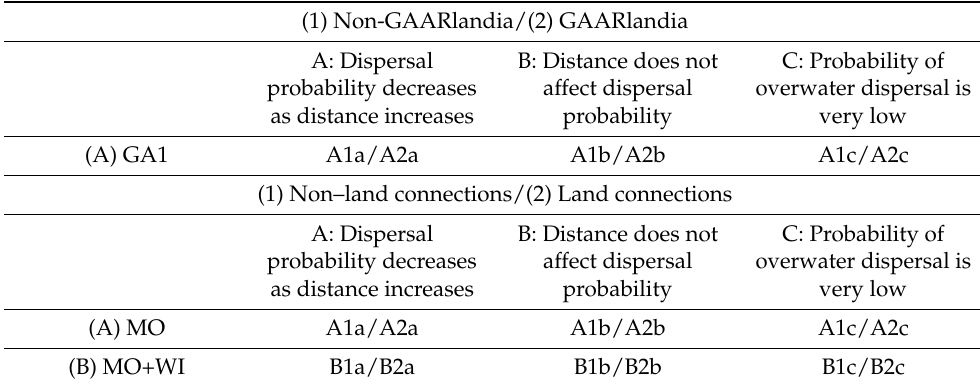
Table 2. Biogeographic specific scenarios analyzed in BioGeoBEARS for (a) Antillattus clade and outgroups and (b) Antillattus clade without outgroups. Each dispersal or vicariance scenario was tested using the six models available in BioGeoBEARS (DEC, DEC+J, DIVALIKE, DIVALIKE+J, BAYAREALIKE, BAYAREALIKE+J). Abbreviations: MO, Mona passage; WI, Windward passage. (1) Non-GAARlandia/(2) GAARlandia A: Dispersal B: Distance does not C: Probability of overwater dispersal is probability decreases affect dispersal very as distance increases probability